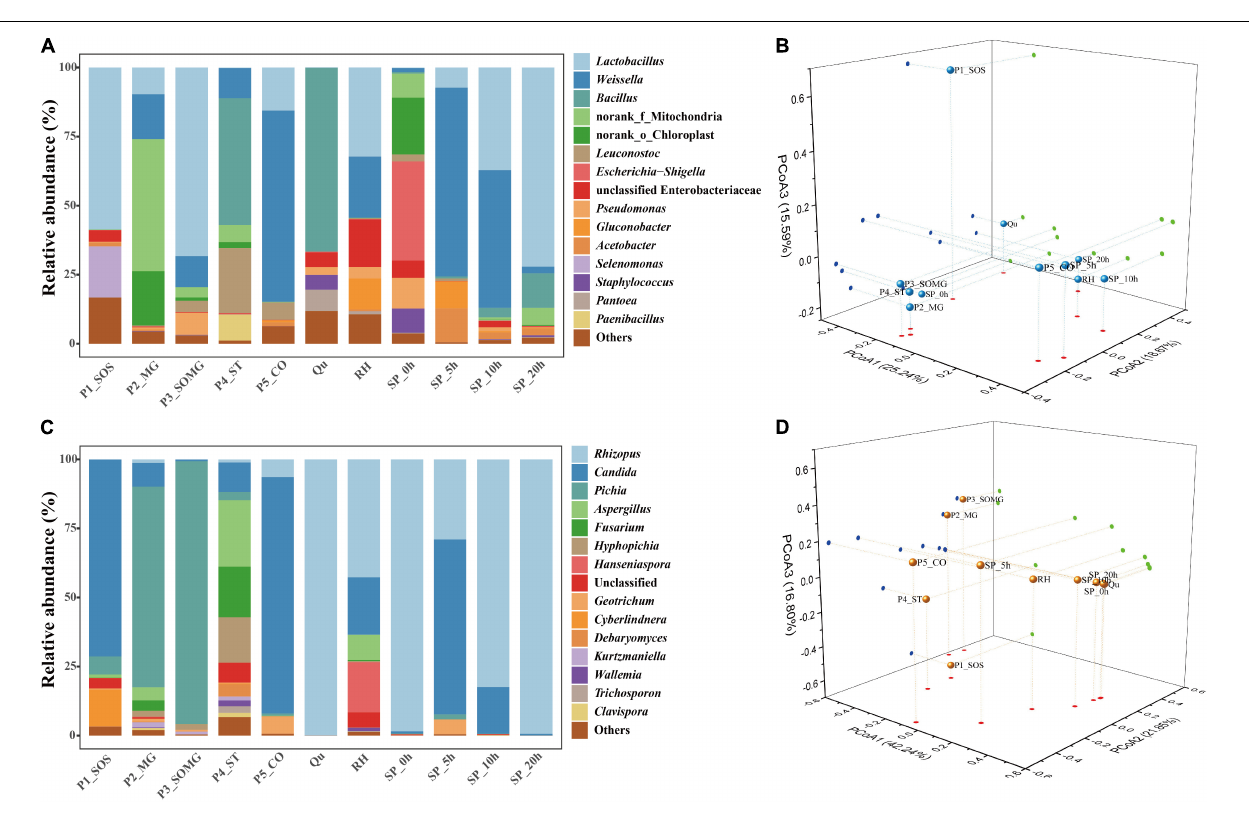
(5.28%). Lactobacillus (32.25%), Weissella (22.13%), unclassified Enterobacteriaceae (17.18%), and Gluconobacter (11.21%) were preponderant genera in